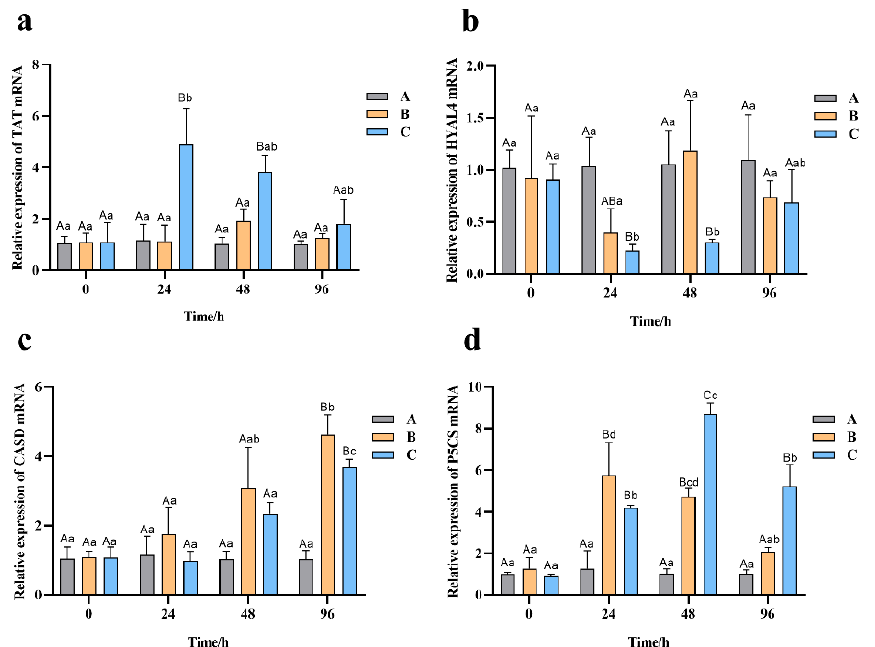
Figure 7. The expression pattern of four candidate genes involved in osmotic pressure regulation under high salinity stress. ( a ) TAT , ( b ) HYAL4 , ( c ) CSAD , and ( d ) P5CS expression levels. Different capital letters represent significant differences between groups treated with different salinity levels at the same time point ( p < 0.05), and different small letters represent significant differences between different time points for the same group ( p < 0.05).